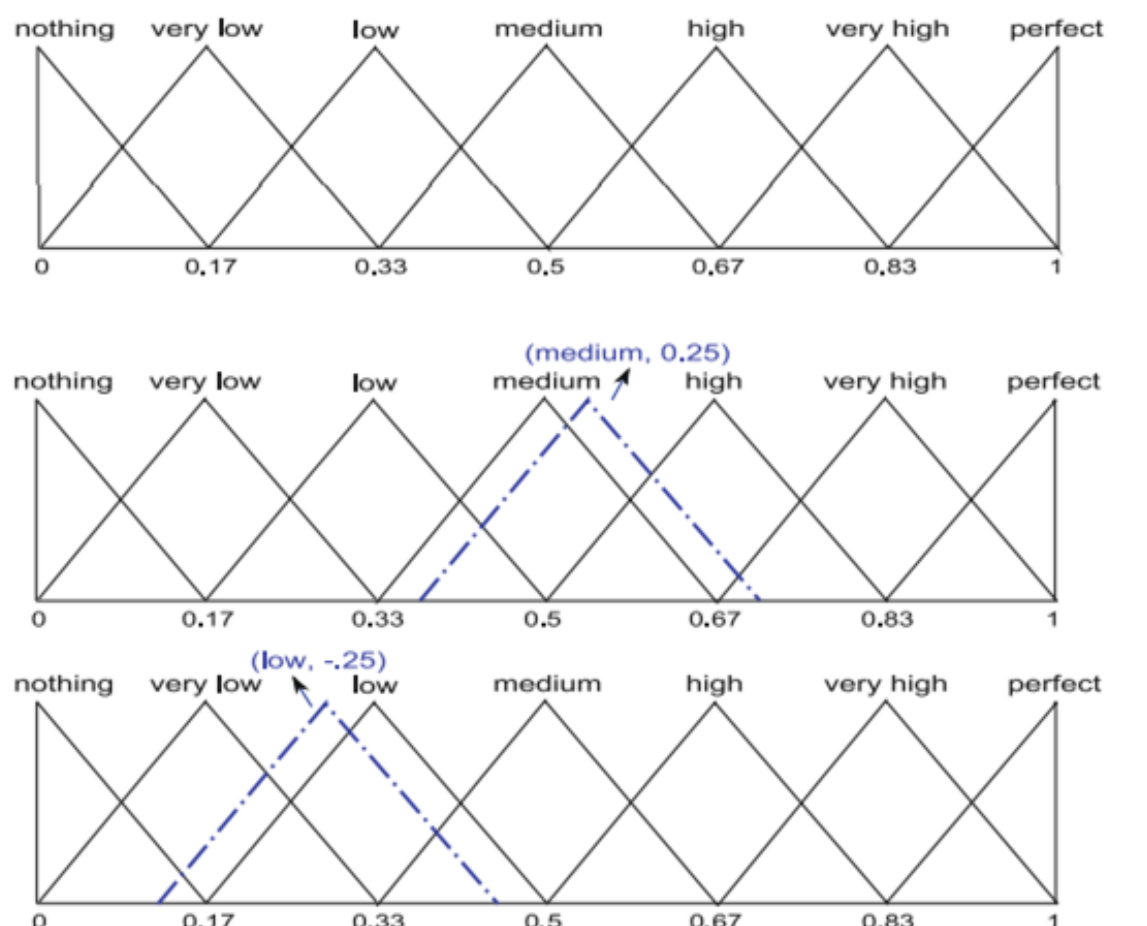
Figure 1. Expressions of 2-tuple linguistic values.